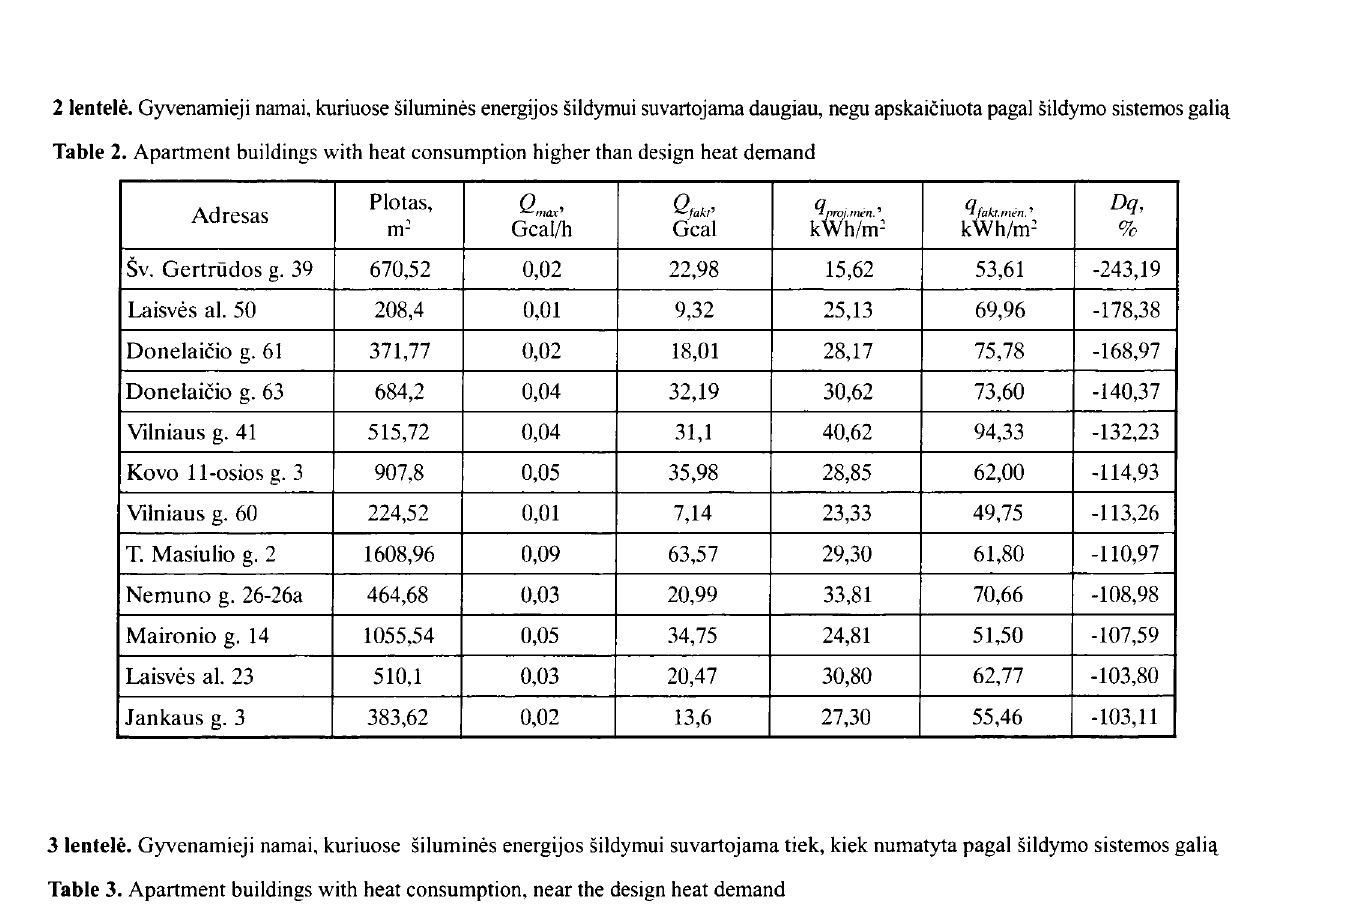
Plotas, Qmax' Qfakr' ~wt;/;n·, qW_men.' Adresas m' Gcal/h Gcal k h/m' % 3482,18 0,25 Baltijos g. 18 2803,15 Riomerio g. 6 731.28 50,13 50,74 -1,21